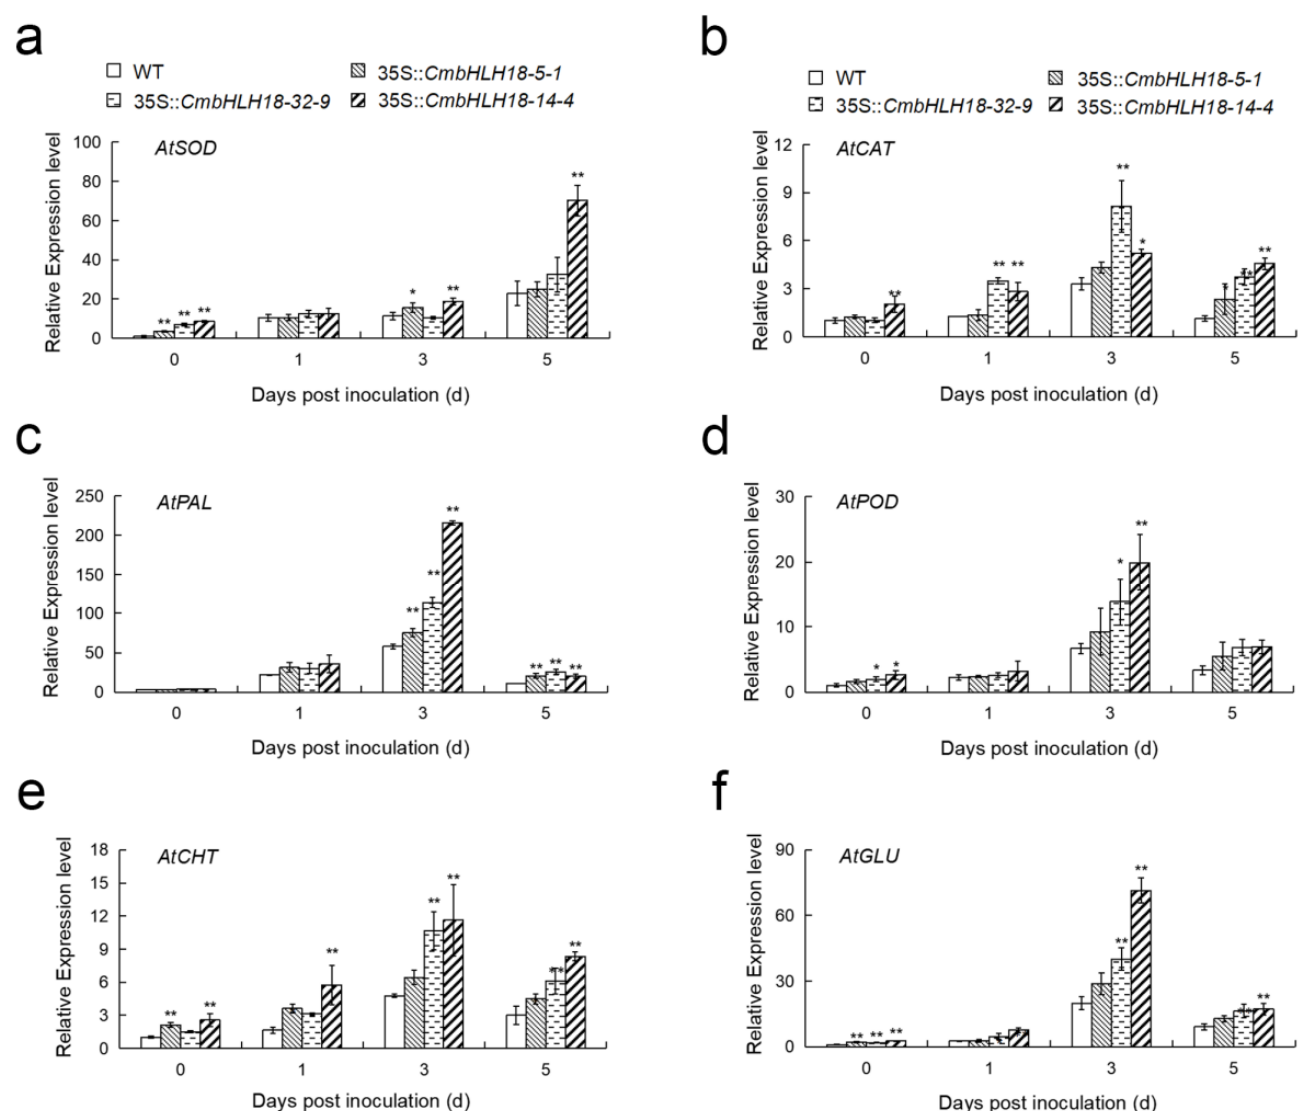
Figure 7. Effect of CmbHLH18 on the expression level of antioxidant and defense enzyme genes in Arabidopsis after inoculation with A. brassicicola . ( a , b ) Expression levels of antioxidant enzyme genes; ( c – f ) Expression levels of defense enzyme genes. Asterisks represent statistically significant differences between different lines by t -test ( n = 3; *, p < 0.05; **, p < 0.01).